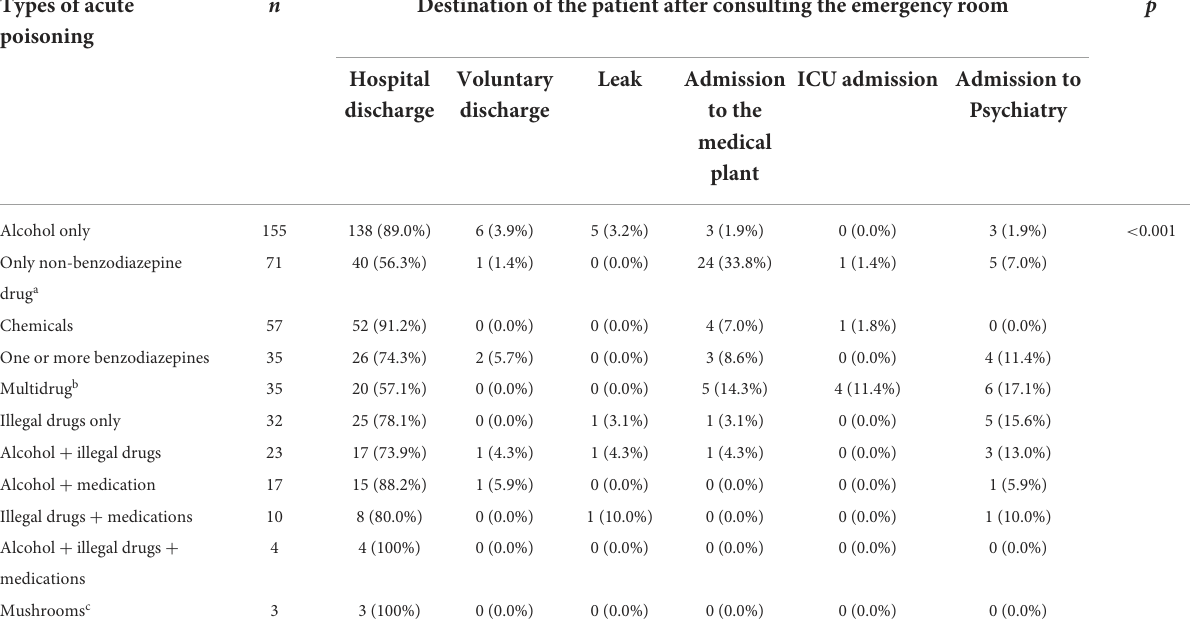
TABLE 2 Differentiates the 11 types of AI found in the study (pure and mixed) and their relationship with the patient’s fate after consulting the emergency